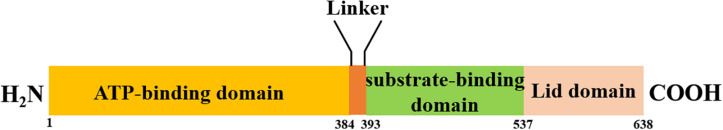
Schematic representation of HSP70s structure. All chaperons in the HSP70 family encompass three main structural domains, namely, an N-terminal ATP-binding domain (NBD) that exhibits ATPase activity, a substrate-binding domain (SBD) to interact with substrates, and a C-terminal lid domain to mediate co-chaperon binding.